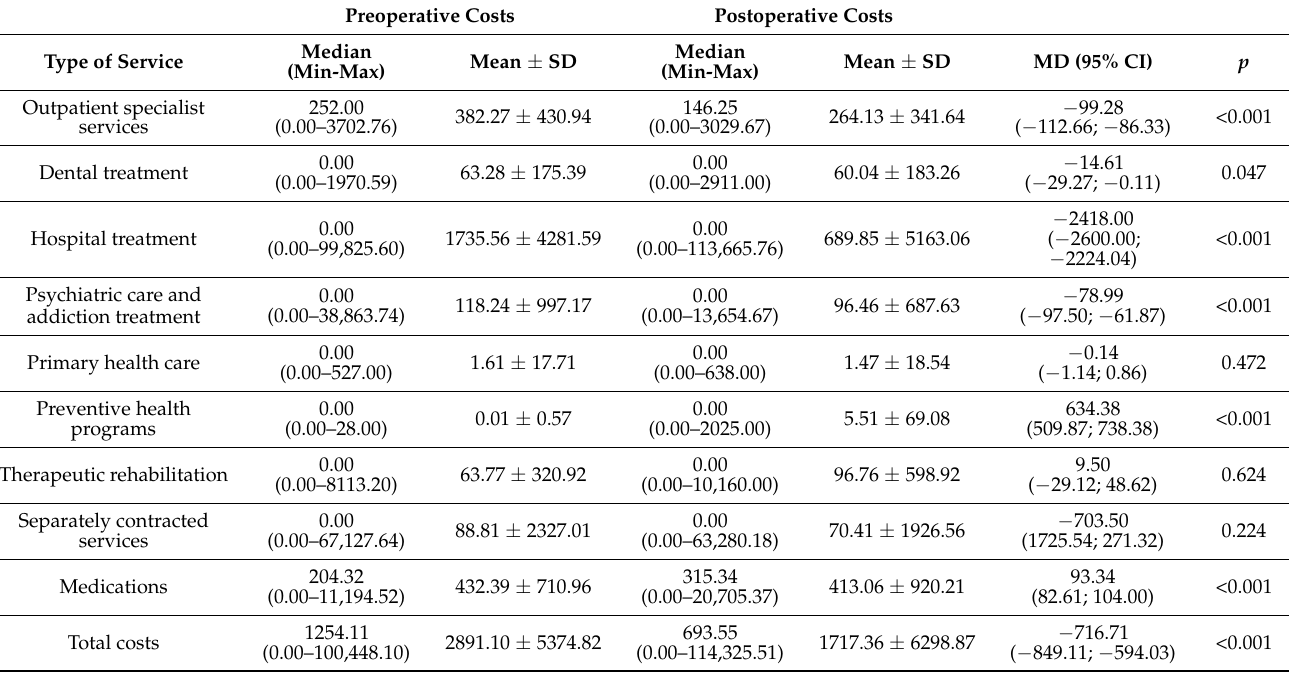
Table 3. A comparison of the preoperative and postoperative mean costs (in PLN) per patient in the study